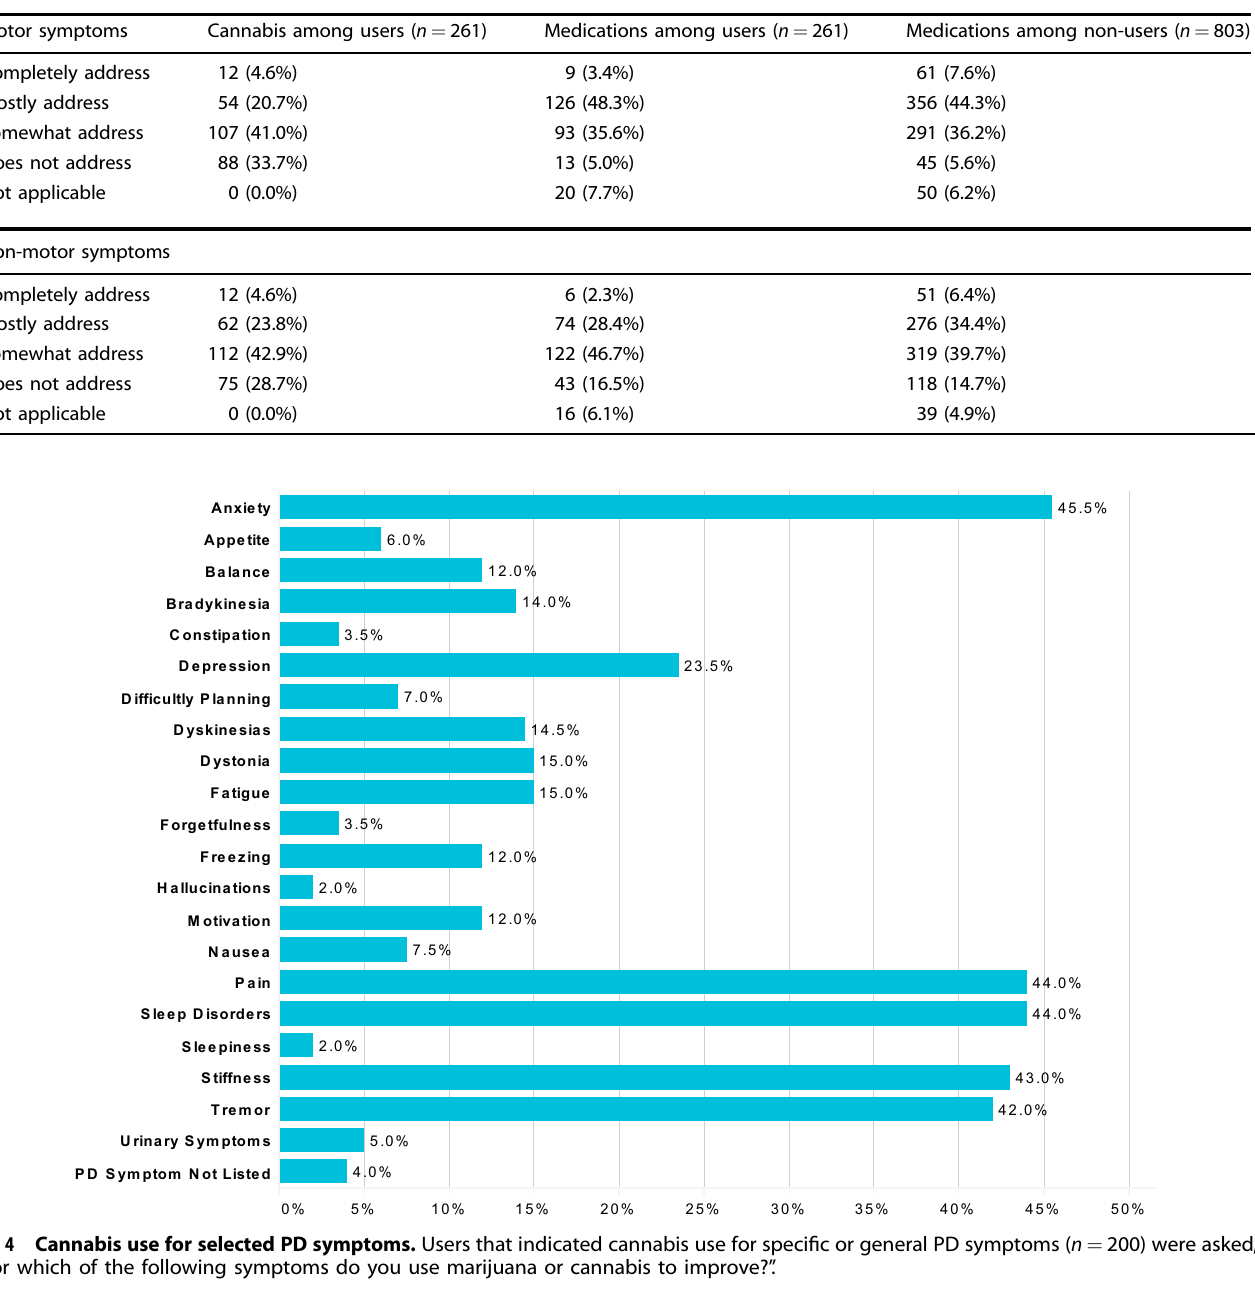
Table 6. Reported symptom satisfaction between cannabis users and non-users, n (%).